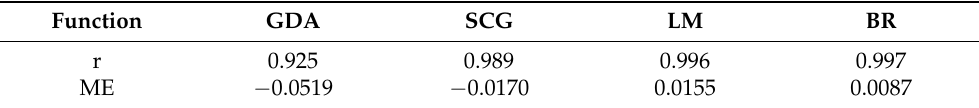
Table 3. r and ME of the different trained functions on the predictions of vertical velocity profiles.